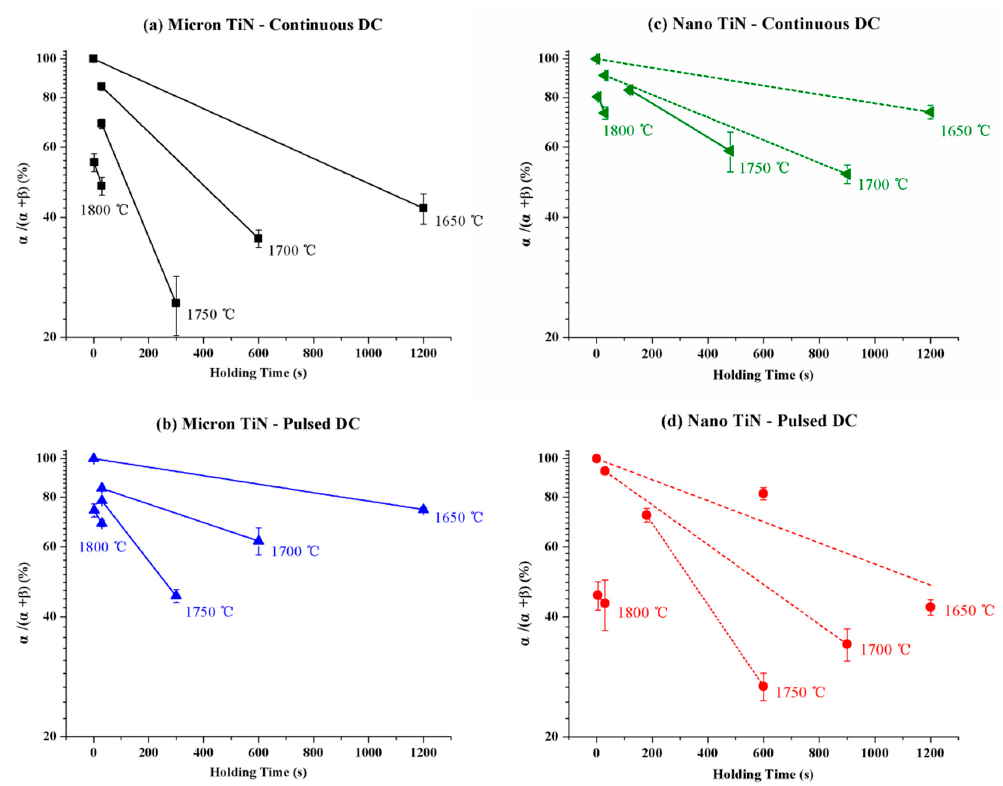
Figure 3. Time dependence of the degree of Si 3 N 4 α -to- β phase conversion fraction for Si 3 N 4 -20 vol % TiN ceramic composites with ( a , b ) micron- or ( c , d ) nano-TiN particles, respectively sintered under ( a , c ) continuous current mode or ( b , d ) pulsed mode; each data point represents the average value, with associated standard deviation error, for current-assisted sintering samples held at a specific temperature for a set dwell time.